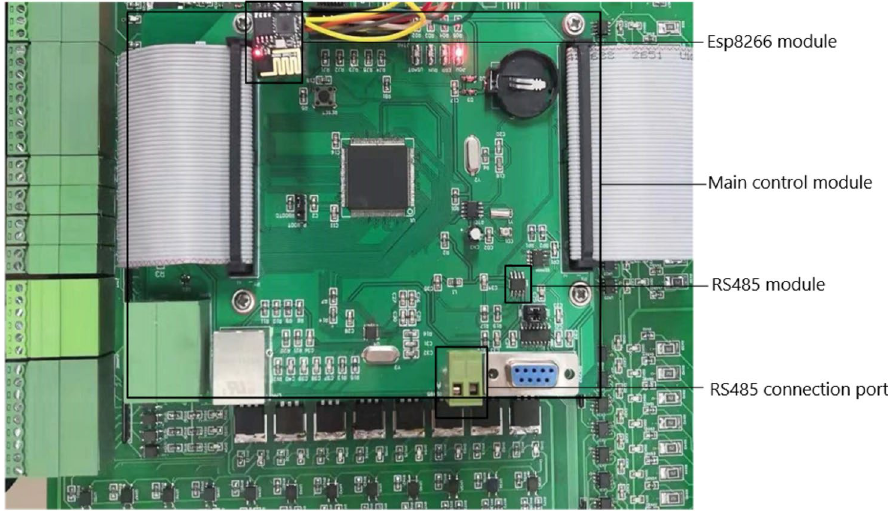
Fig. 3 Main control module PCB